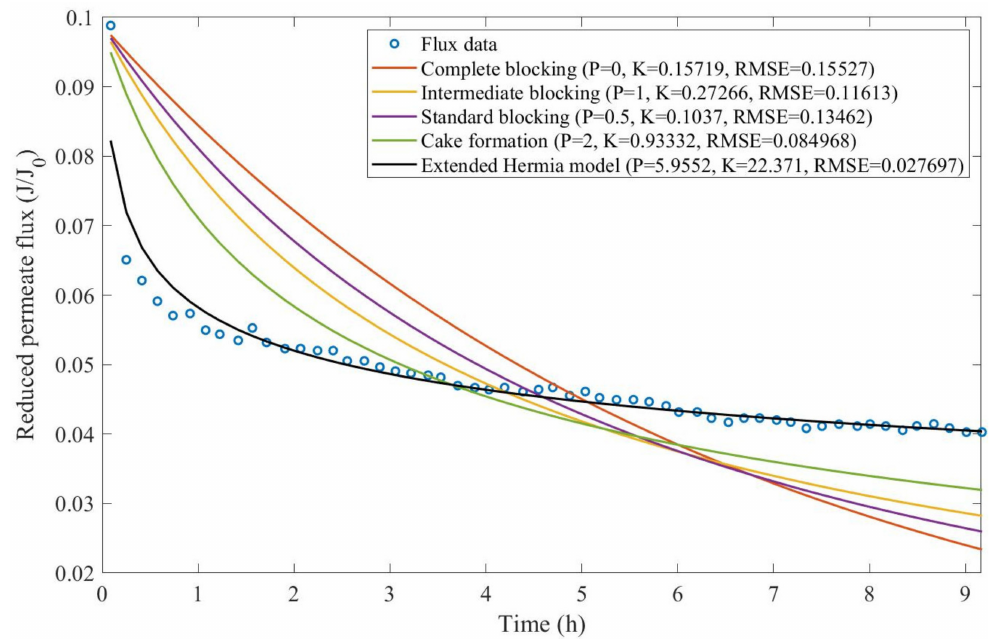
Figure A27. Model fitting for ultrafiltration of flooding wastewater at 2.20 bar and cross-flow velocity of 1.50 m/s considering the four original pore blocking mechanisms and the extended Hermia model